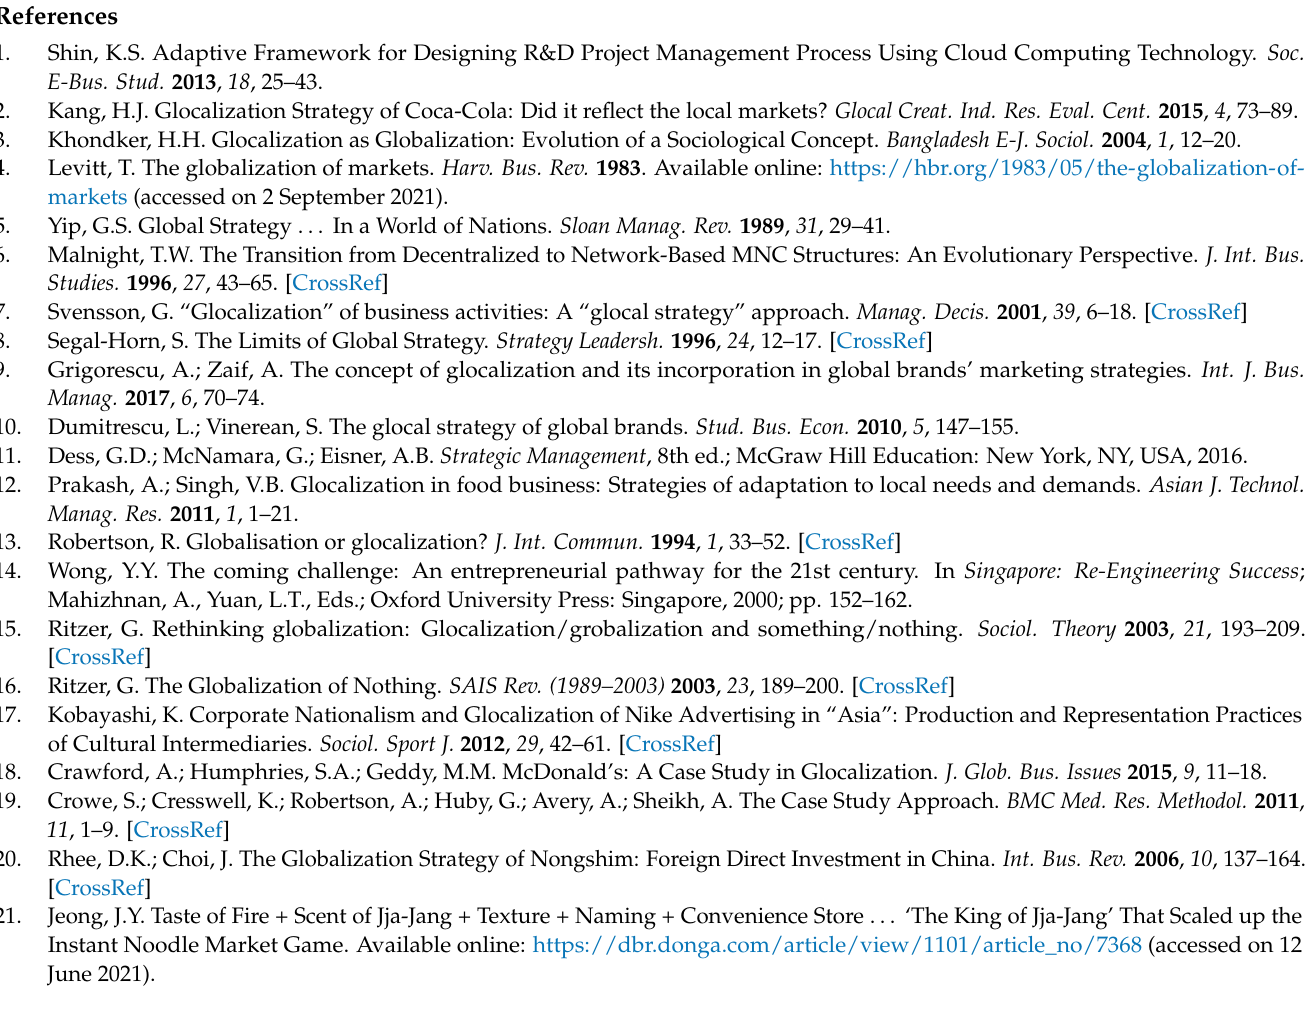
Figure A3. Nongshim’s share of the US Instant Noodles Market. Source: Nongshim, KB Securities (Park A.R. 2019) [58].